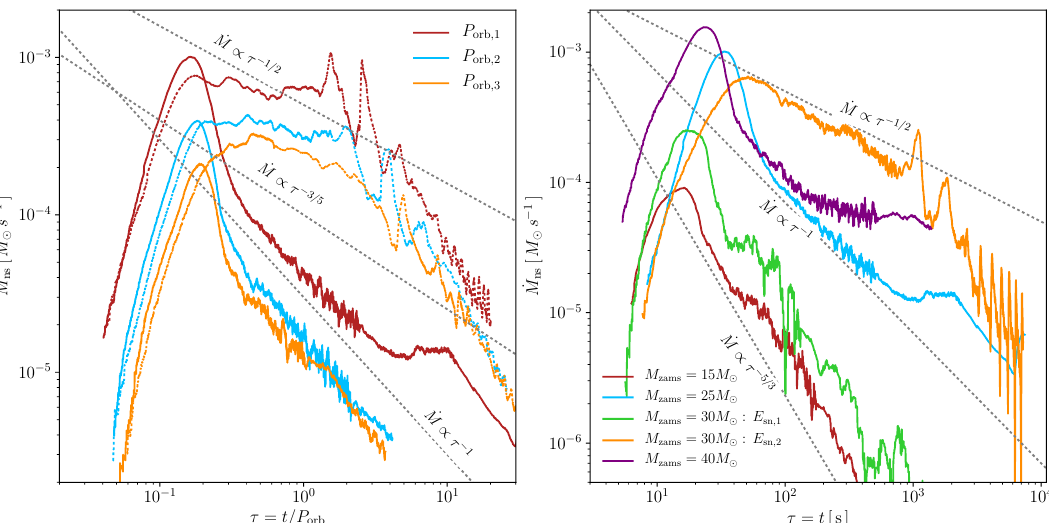
Figure 10. ( a ) Mass-accretion rate onto the NS companion in the IGC scenario (taken from Figure 9 in [90]). Different colors correspond to different initial orbital periods: P orb,1 = 4.8 min (red line), P orb,1 = 8.1 min (blue line), P orb,1 = 11.8 min (orange line). The other parameters that characterize the initial binary system are the same as in Figure 9. The solid lines correspond to a SN energy of 1.57 10 51 erg, while the dotted ones correspond to a lower SN energy of 6.5 10 50 erg. It can be seen × × that the mass-accretion rate scales with the binary orbital period. ( b ) Mass-accretion rate on the NS companion for all the CO core progenitors (see Table 1 and Figure 13 in [90]). The NS companion has an initial mass of 2 M and the orbital period is close to the minimum period that the system can have (cid:12) in order that there is no Roche-lobe overflow before the collapse of the CO core : 6.5 min, 4.8 min, 6.0 min and 4.4 min for the M zams = 15 M , 25 M , 30 M and 40 M progenitors, (cid:12) (cid:12) (cid:12) (cid:12)